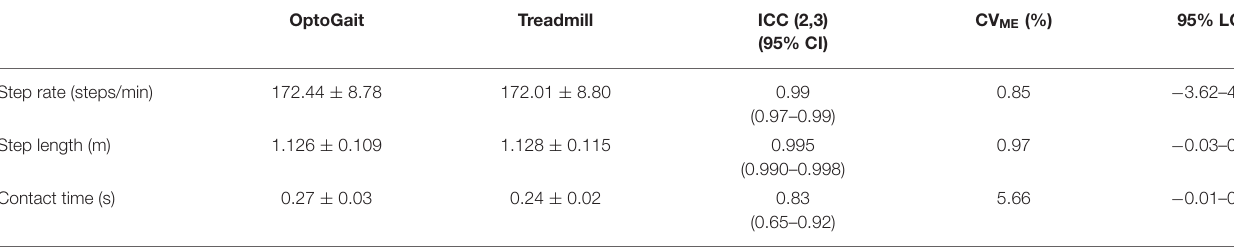
TABLE 1 | Means, standard deviations, and limits of agreement of running parameters using OptoGait and instrumented treadmill.